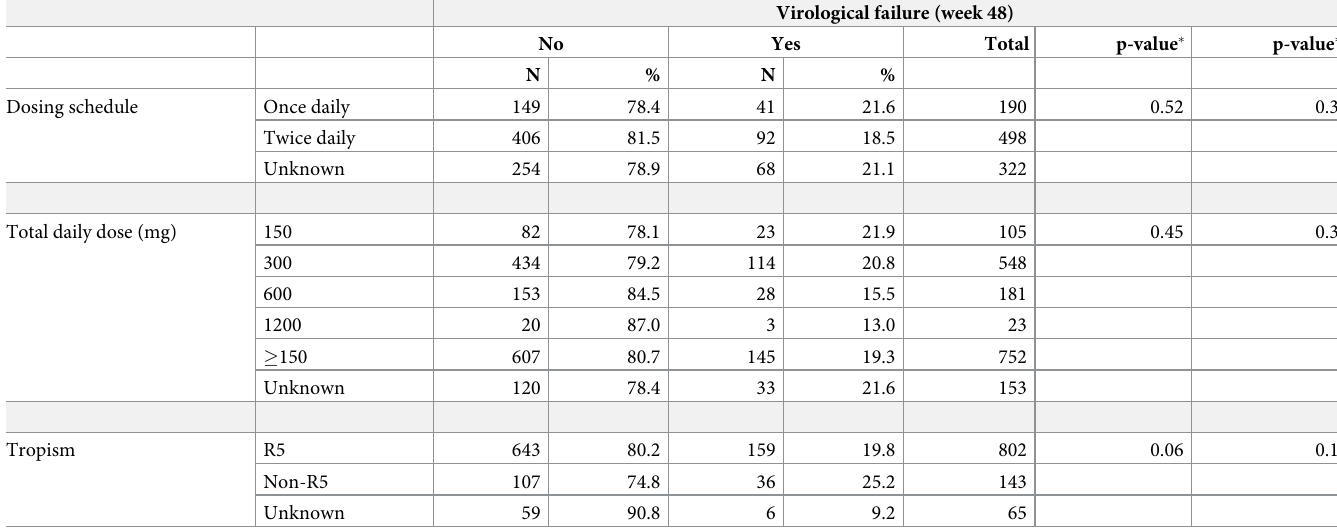
Table 7. Univariate logistic regression analysis of the association between non-standard maraviroc uses and virological failure.